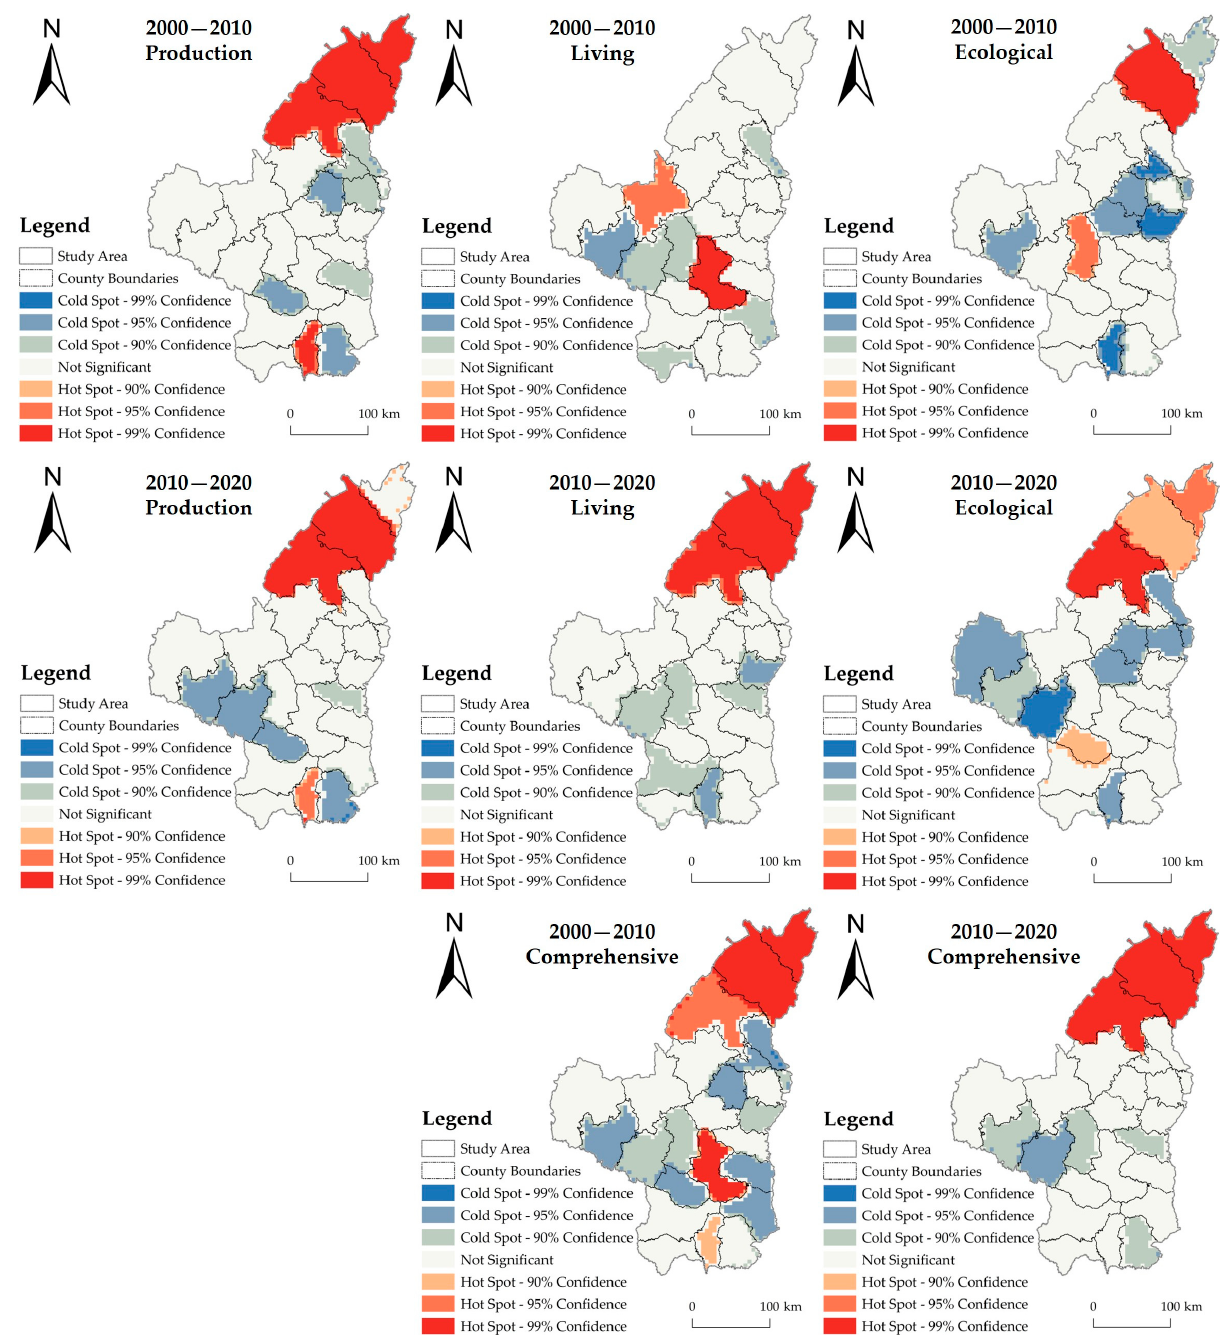
Figure 4. Hot spot distribution of human settlement environment niche.